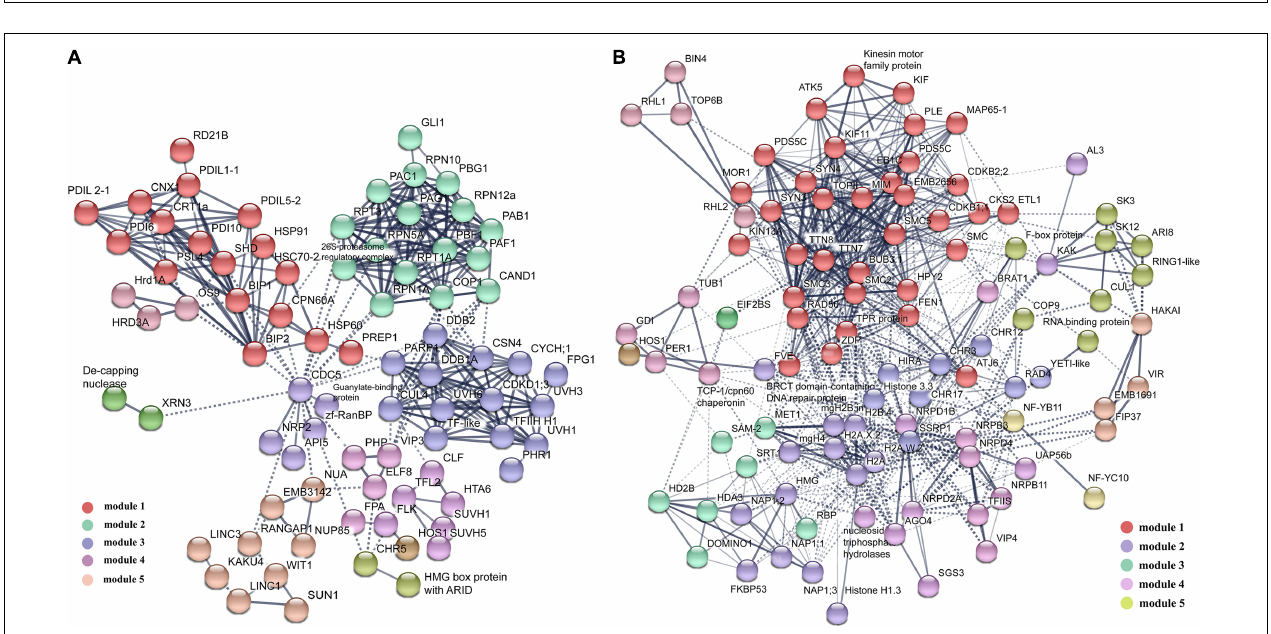
FIGURE 3 | GO functional enrichment analysis of 720 DAPs by REVIGO. The left scatterplot shows significantly enriched GO terms related to biological processes in VN, and the right scatterplot showed significantly enriched GO terms in GN. GO terms are represented by circles and are clustered according to semantic similarities to other GO terms in the gene ontology (more general terms are represented by larger size circles, and adjoining circles are most closely related). Bubble color indicates the log10P-value for the enrichment derived from the AgriGO analysis, and bubble size is proportional to the frequency of the GO term. The statistically most significant GO terms are highlighted by annotation.